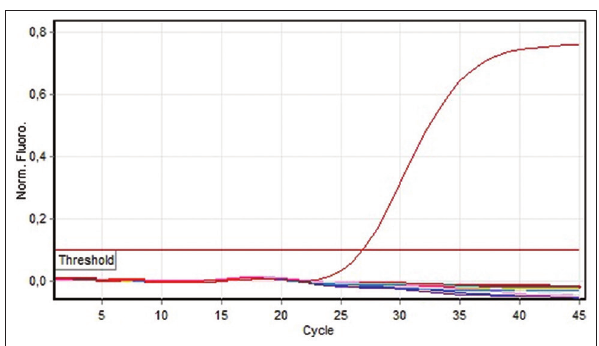
Figure-1: Reverse transcription-polymerase chain reaction of RNA samples from coronavirus disease 2019-suspected pets. Positive control reaction